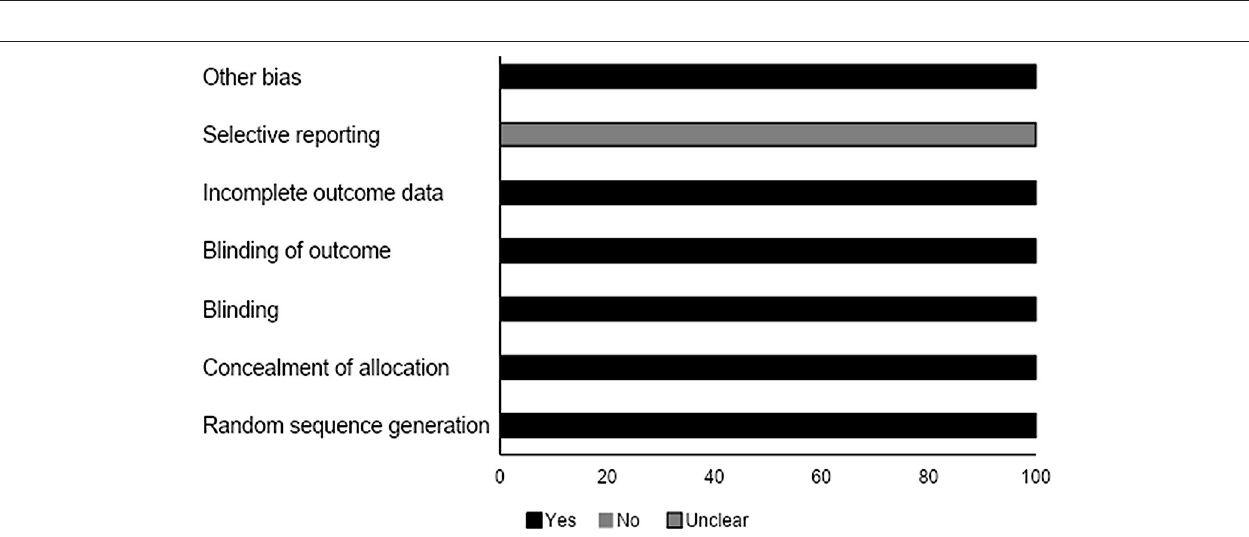
FIGURE 4 | Risk of bias according to the Cochrane risk of bias assessment for the randomized controlled trials.